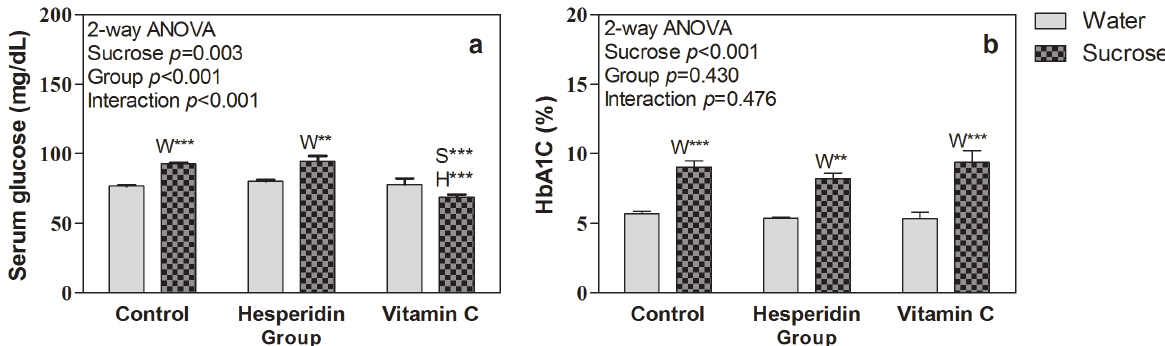
Figure 1 - Influence of vitamin C and hesperidin on fasting glucose ( a ) and glycated hemoglobin (A1C) ( b ) in rats treated with sucrose. p : level of significance according to post-hoc test in two-way ANOVA test in relation to water control (W), sucrose control (S), and hesperidin (H) at ** p <0.01 and *** p